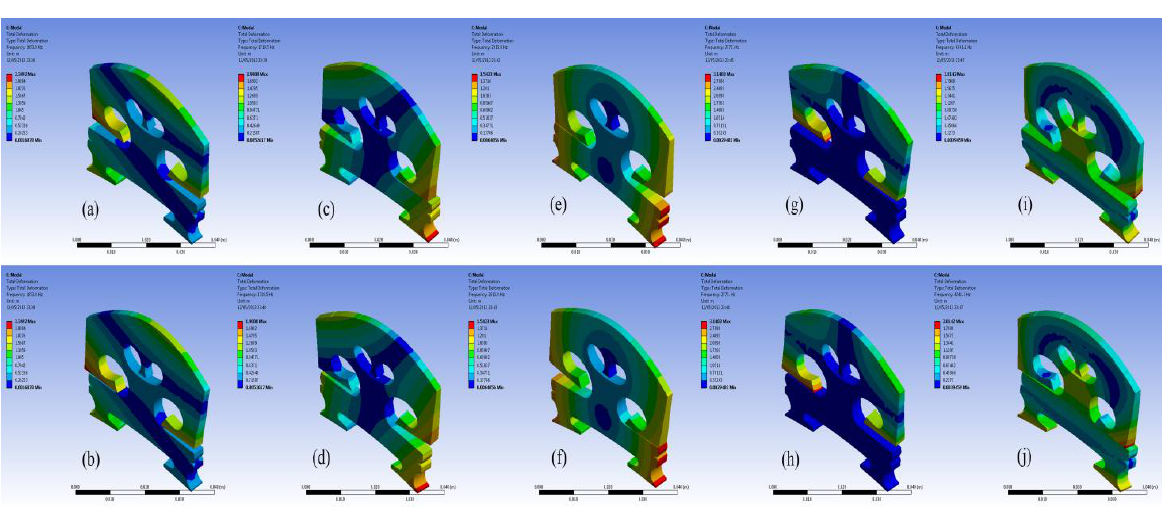
Figure 7. Bridge motion of the five major resonance modes at 1,654 Hz ( a , b ), 1,720 Hz ( c , d ), 2,616 Hz ( e , f ), 2,775 Hz ( g , h ), and 4,241 Hz ( i , j ) in the case of EFS1 = 0.001 N/mm 3